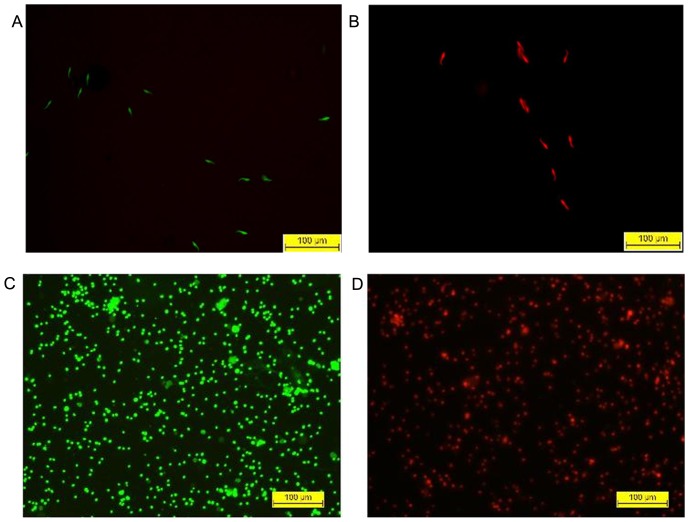
The sperm viability, as assessed by a fluorescent staining method.Rat Sperm viability assessment by SYBR-14/PI staining. (A) Control rat sperm appear green due to uptake of SYBR14 only; (B) DGT-treated rat sperm appear red due to uptake of PI when observed under a fluorescence microscope. Overlaid fluorescence images of (C) control and (D) DGT-treated human spermatozoa, dual stained with SYBR-14 and propidium iodide to distinguish green-fluorescing live from red-fluorescing dead spermatozoa.